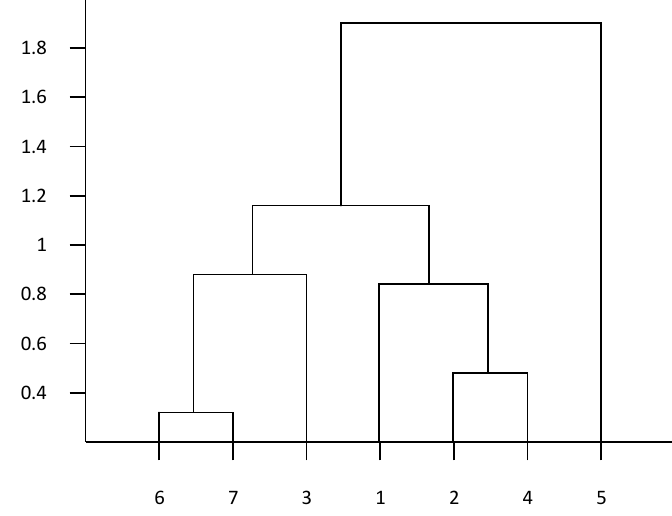
Figure 1. Cluster analysis of drug